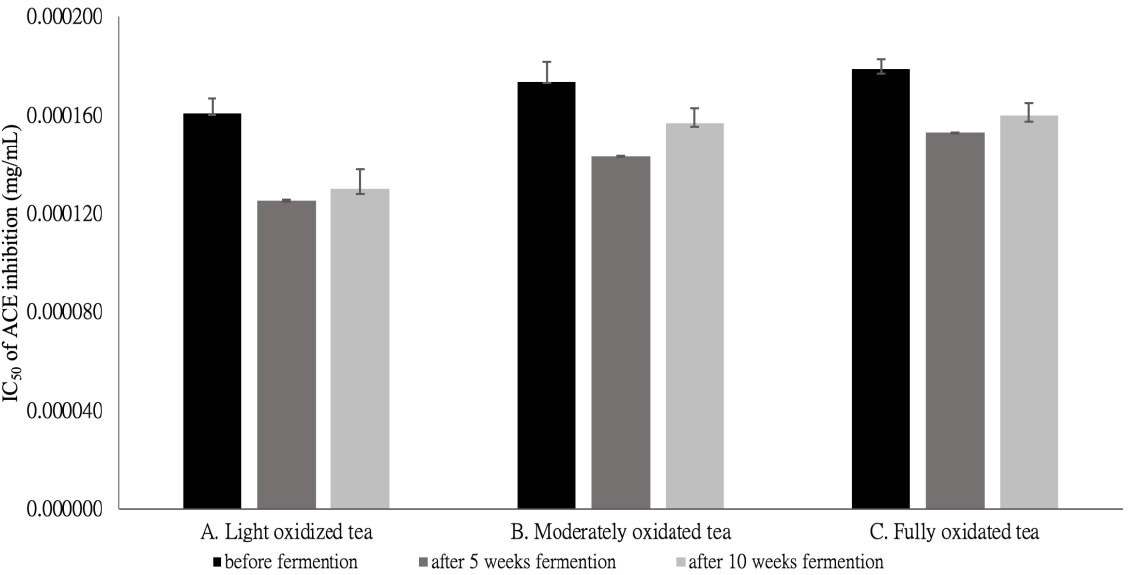
Figure 4. Effect of IC50 on ACE inhibition activity of Chin-shin oolong tea fermented with three different oxidized levels: before fermentation, after 5 weeks, and after 10 weeks. A. Lightly oxidized tea. B. Moderately oxidized tea. C. Fully oxidized tea.